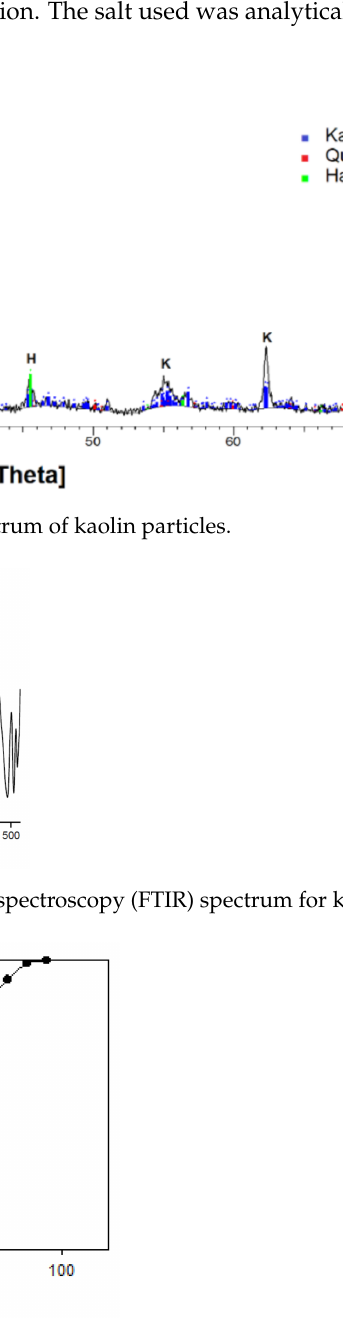
Figure 3. Particle size distribution of a mixture of quartz and kaolin in distilled water at natural pH. Mechanical agitation was maintained